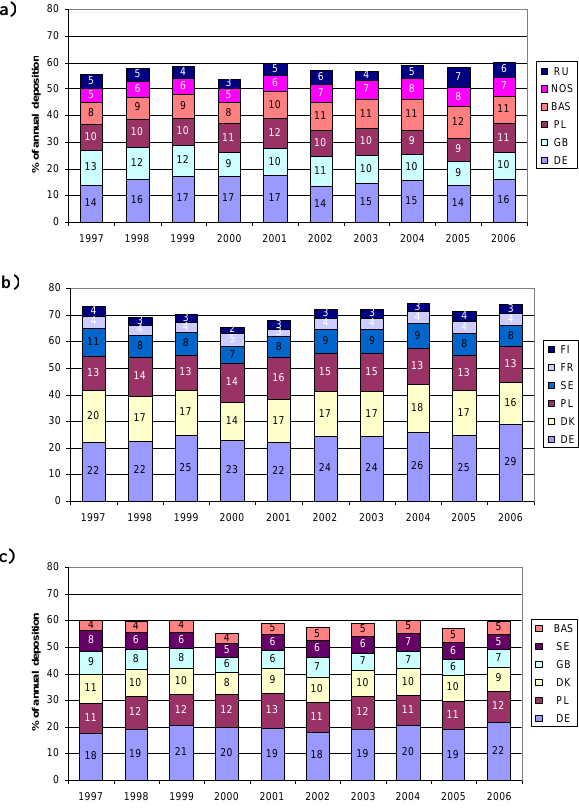
Fig. 15. Time series of main contributions to annual deposition of nitrogen into the Baltic Sea basin in the period 1997–2006. Contributions are in % of: (a) oxidised, (b) reduced and (c) total